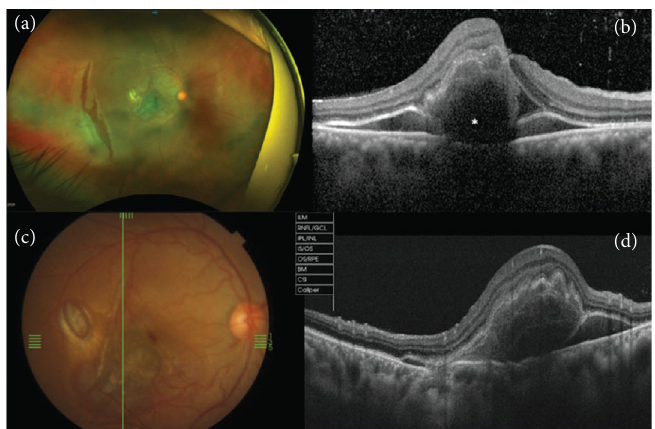
Figure 1: (a) A wide- fi eld preoperative photograph shows limited moderate submacular hemorrhage associated with a parafoveal choroidal rupture and an irregular-shaped posterior retinal tear. (b) A swept-source cross-sectional optical coherence tomography (OCT) image in the horizontal plane shows a submacular hemorrhage that appears hyperre fl ective; it is hemoglobin-rich ( ∗ ) and hypore fl ective when the serous component is predominant. Due to the presence of blood, there is attenuation of the IS/OS (inner segment/outer segment) band and RPE (retinal pigment epithelium) line. (c) Posterior pole preoperative clinical photography and (d) corresponding swept-source cross-sectional OCT image in the vertical plane depict an elevated preoperative central submacular hemorrhage and an RPE attenuation-like